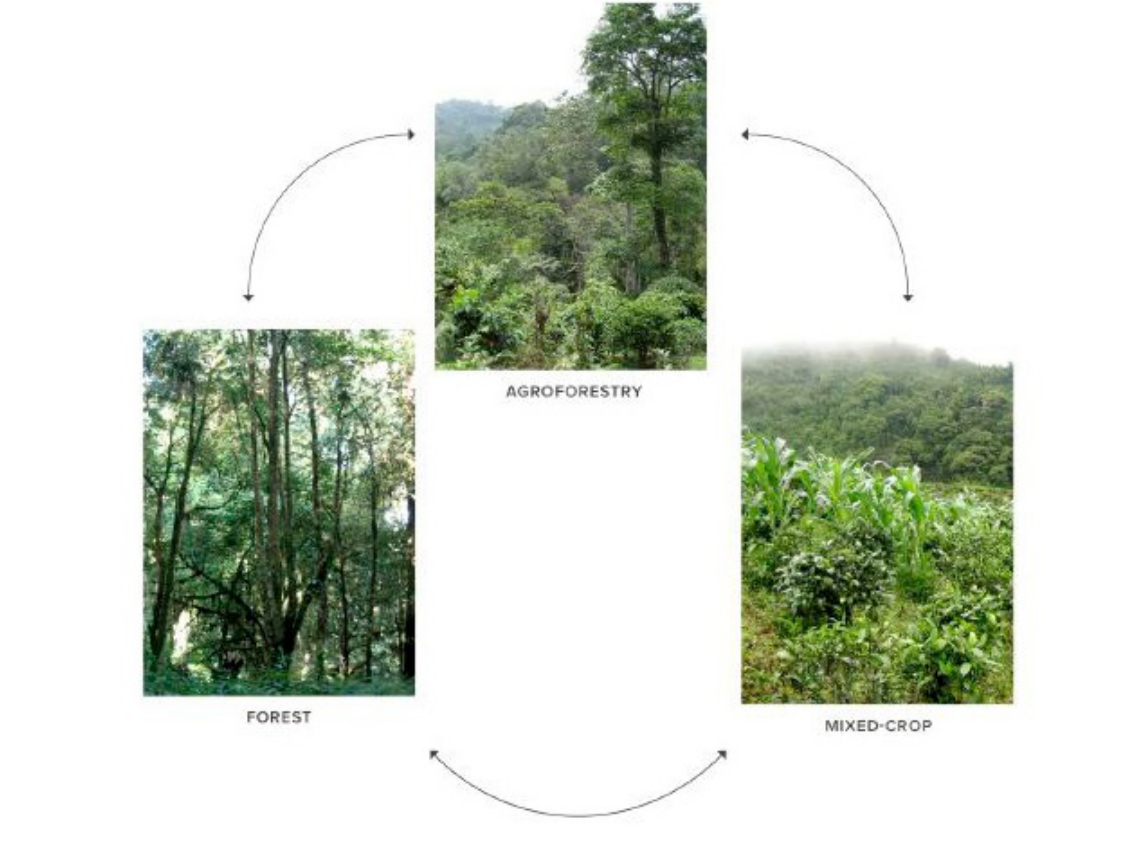
Fig. 1. Cyclical nature of traditional tea production systems in southern Yunnan between forest, agroforest, and mixed-crop